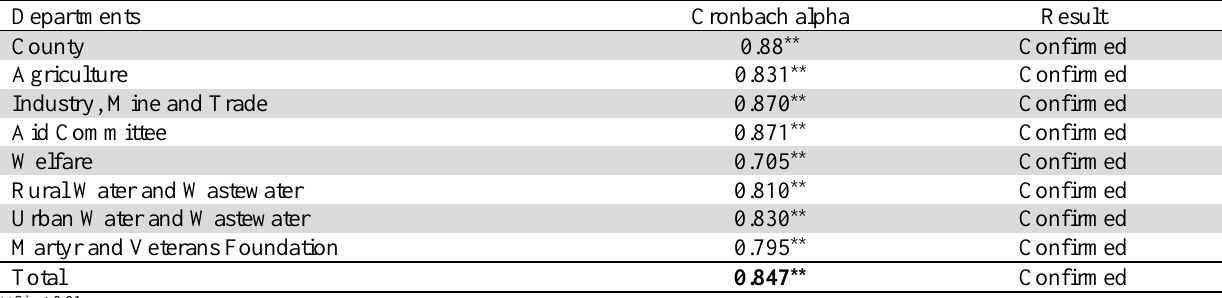
Correlation test between corporation culture and organizational success in all departments of Khorasan Razavi